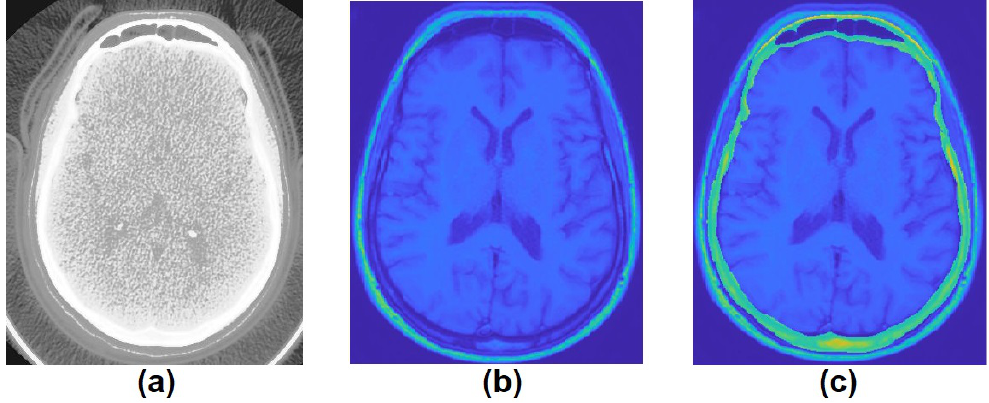
Figure 3. ( a ) CT scan, ( b ) MRI, and ( c ) STL model extracted from CT scan overlapped in MRI. Finally, all images were normalized between the range of 0 and 1 and then resized to 256 × 256 using nearest-neighbor interpolation method to improve the processing